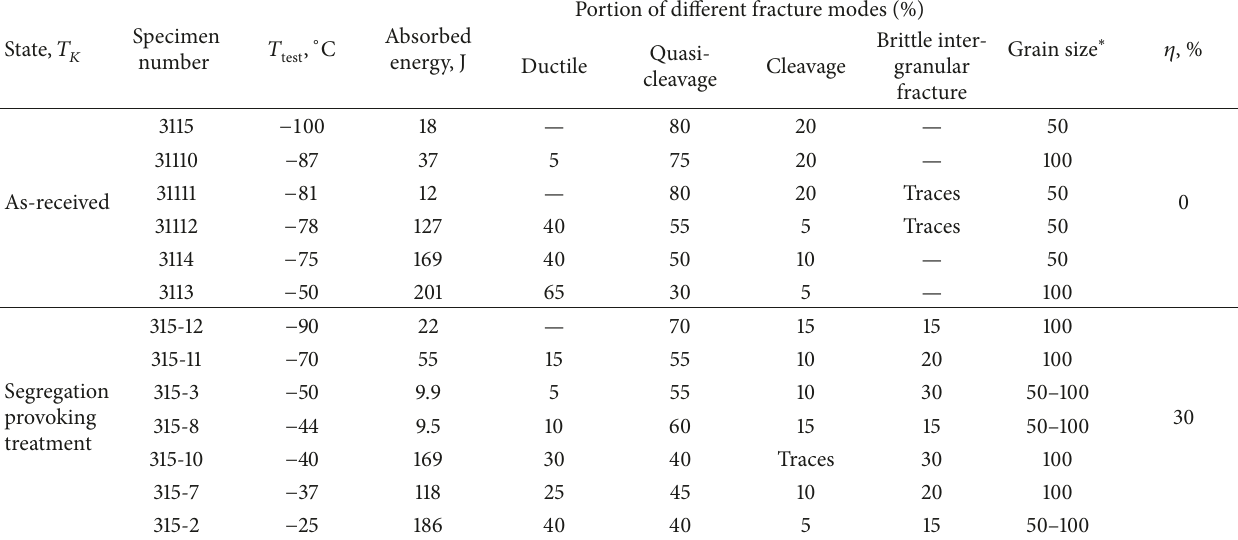
Table 3: Results of fractographic analysis for 15Kh2NMFAA steel specimens in different states.